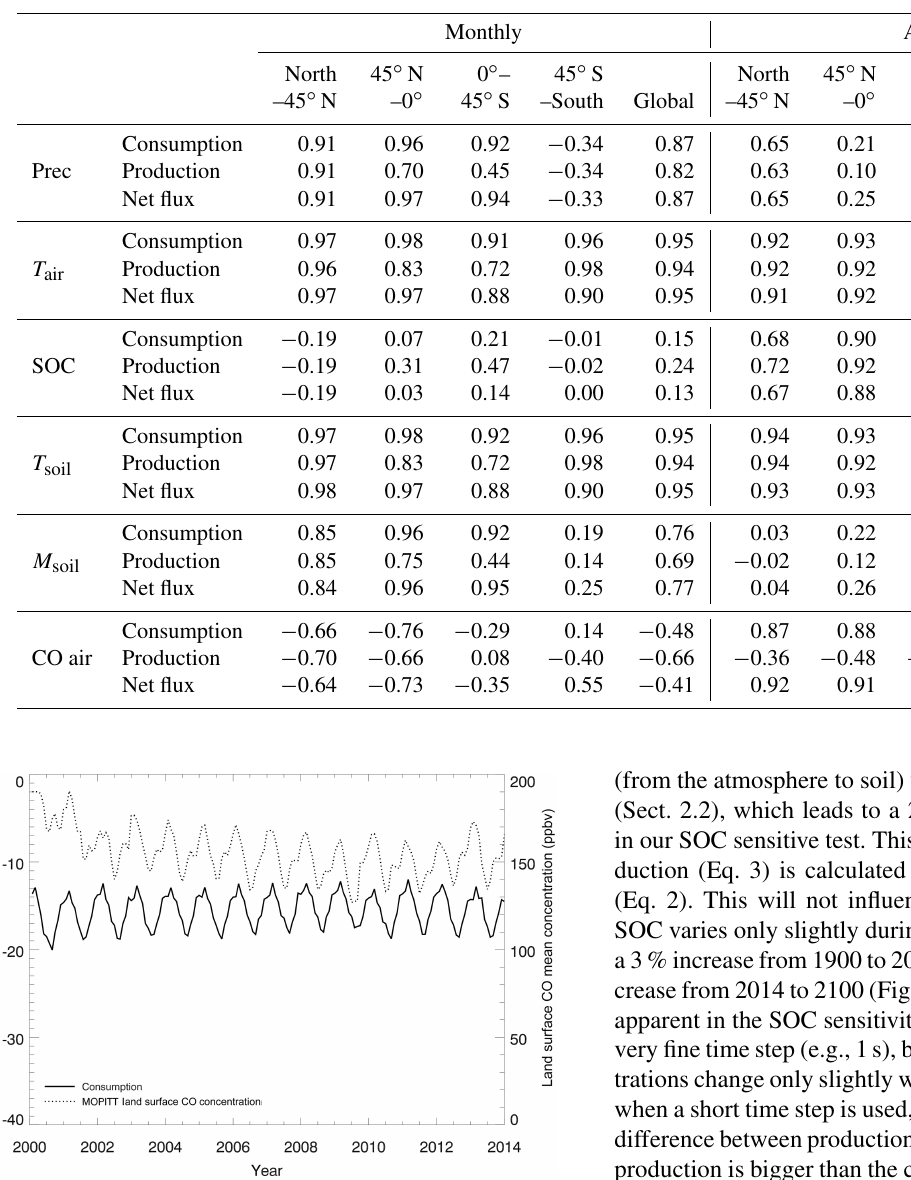
Figure 11. Global mean monthly time series of the MOPITT sur- face atmospheric CO concentration (ppbv) and soil CO consump- tion from model simulations E1 (TgCOmon − 1 )